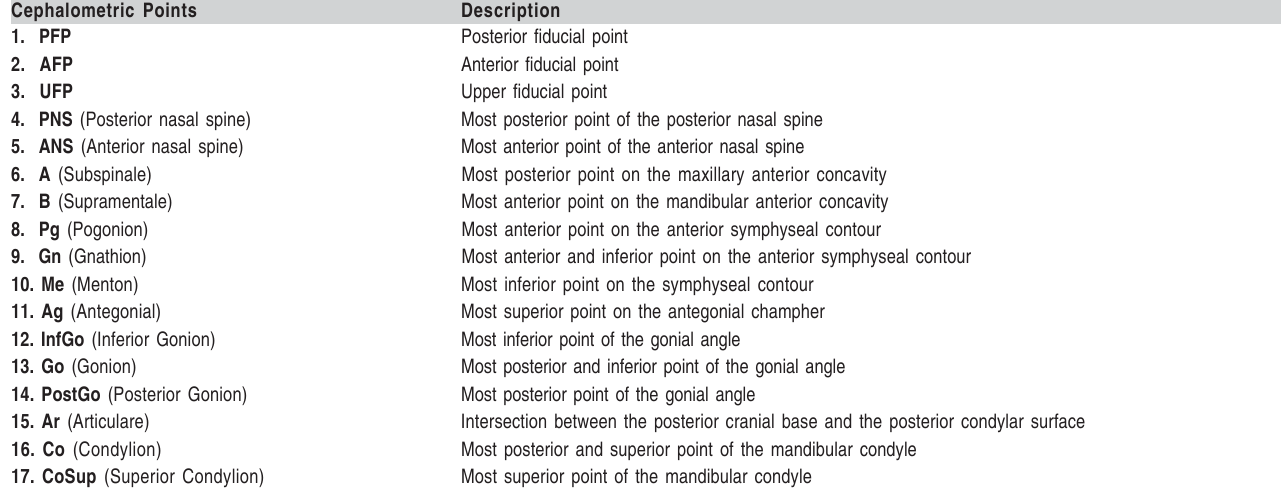
Table 3 - Digitized cephalometric points.